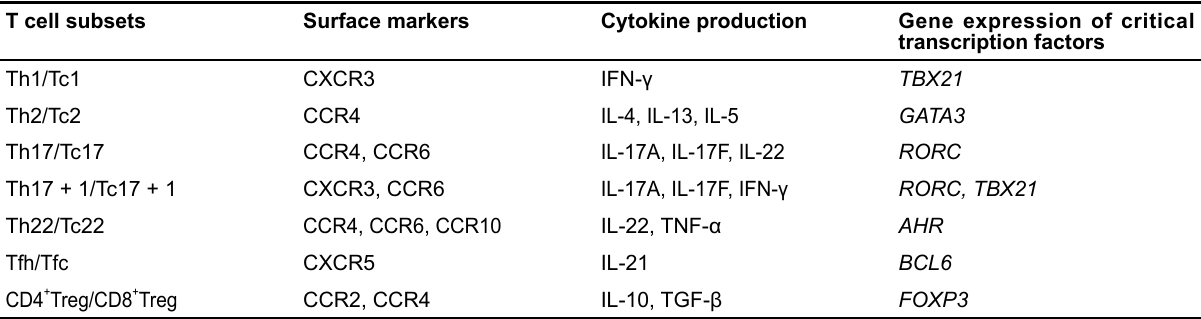
IL-10, TGF-β FOXP3 Tfh: T follicular helper; Tfc: T follicular cytotoxic; Treg: regulatory T; TGF: transforming growth